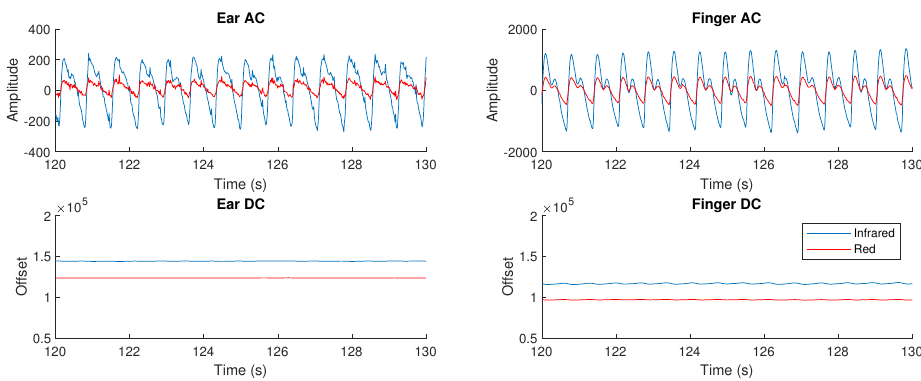
Figure 4. Examples of the alternating current (AC) and direct current (DC) waveforms within a PPG measurement, from both the right ear canal and the right index finger. The amplitude is lower in the right ear canal for both the red and infrared signals, but the signal is clear and usable. The maximum to minimum amplitude was designated as the AC signal amplitude, which is divided by the DC signal in the ratio of ratios metric to calculate SpO 2